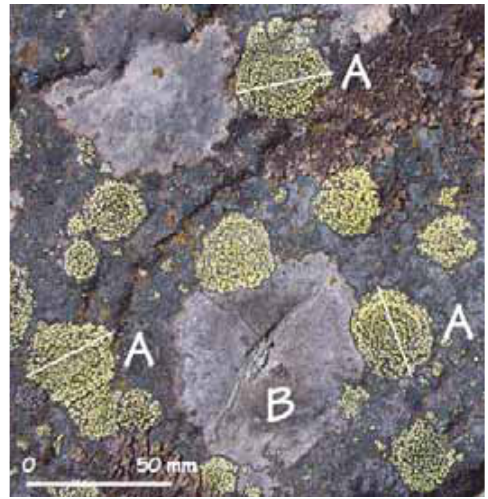
Fig. 3. Lichens growing on a rockfall block at the Barretts landslide site. A wide range of sizes for Rhizocarpon subgenus Rhizocarpon is shown. These lichens have the typical salt-and-pepper texture of most yellow rhizocarpons. Three of the largest li- chens at locations A are nearly the same size; 33.46, 34.09, and 34.32 mm. The white lines indicative of the longest axis maximum diameter include the black algal rim, which is part of the lichen. The top lichen is a composite of several yellow rhizocarpons, but the isolated nature of most lichens suggests that this is a first-generation community of lichens. The lichen at B is a fast-growing crustose lichen that would require a separate growth